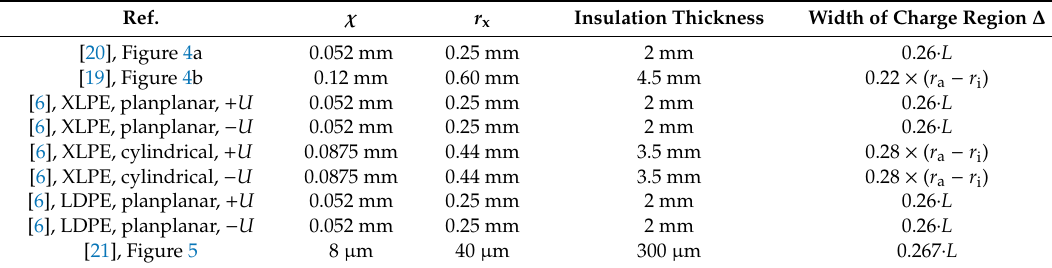
Table 2. Distance constants χ and positions r x for the simulation of space charge measurements in [6,19–21]. The absolute value of the applied voltage is | U | = 20 kV.